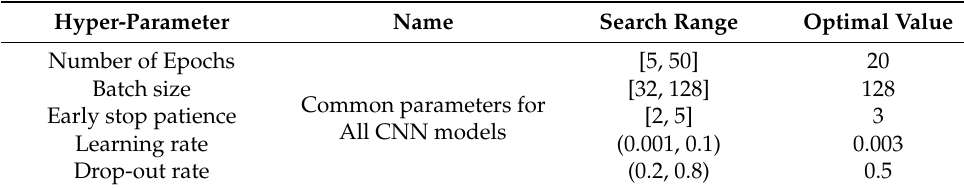
Table 3. CNN models